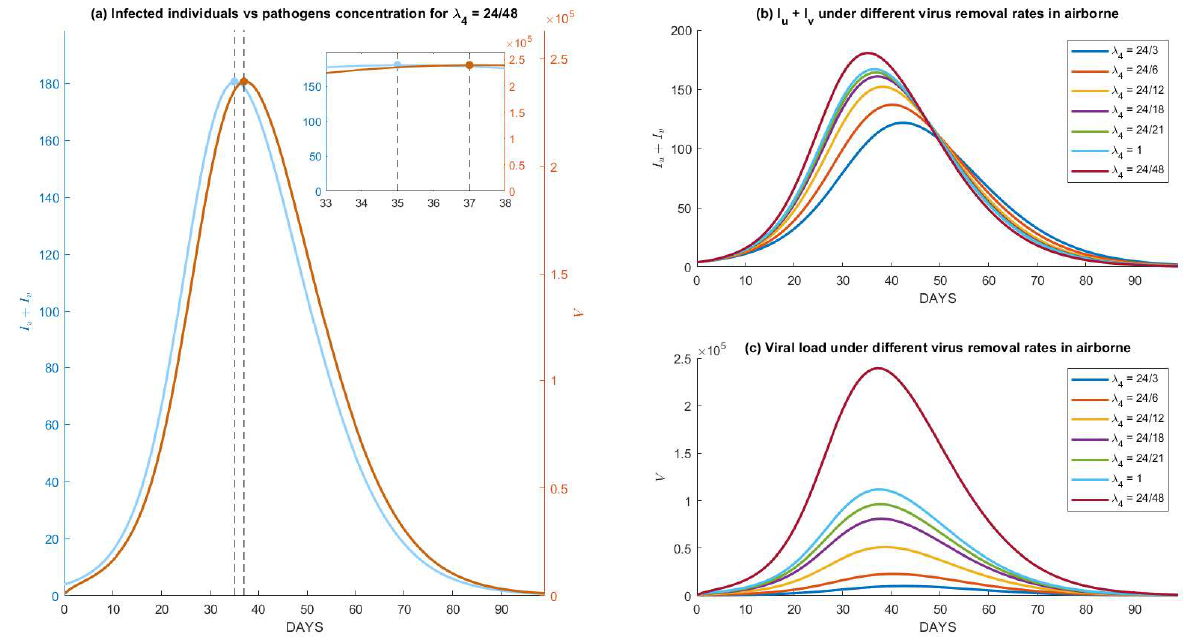
Figure 5. Numerical simulations of System (1) and (2) under different removal rates of airborne pathogens, that is implicated in the critical period of pathogens to remain active airborne: ( a ) comparison between the dynamics for infected individuals and viral load for a critical period of 48 h, which shows an exact lag of 48 h between the peak of infections and its viral loads, ( b , c ) dynamics for I u + I v and its viral load under different critical periods of the airborne pathogen.